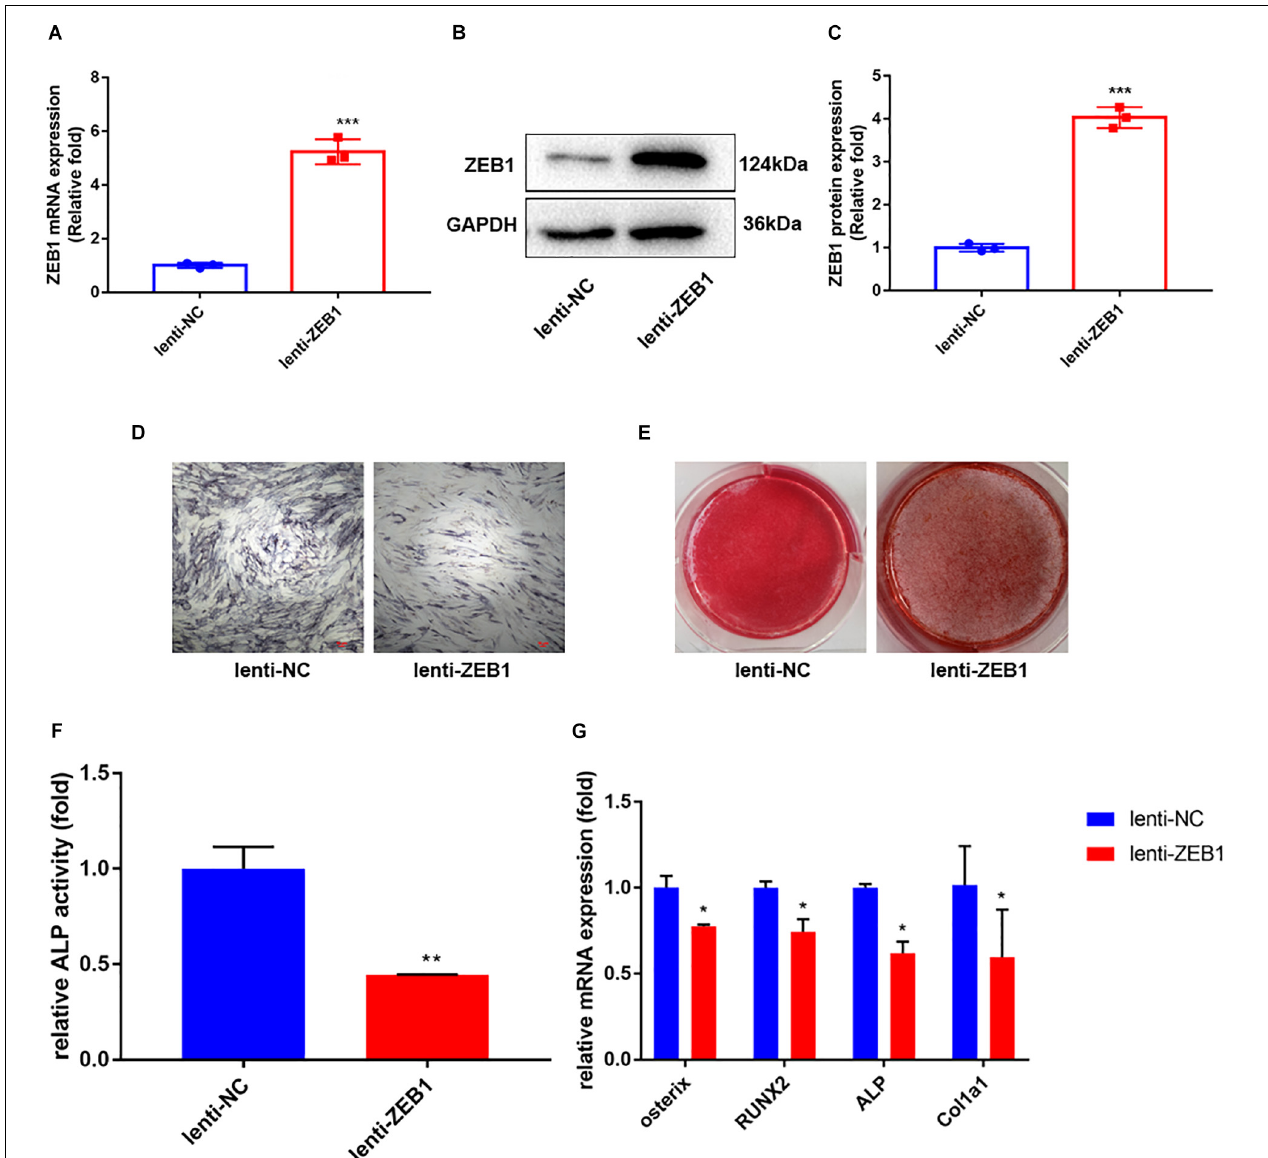
FIGURE 3 | Zinc finger E-box-binding homebox 1 (ZEB1) upregulation inhibited the osteogenesis of hBMSCs. (A) ZEB1 expression increased after lenti-ZEB1 treatment – evaluated by qRT-PCR. (B,C) ZEB1 expression increased after lenti-ZEB1 treatment – evaluated by western blotting. (D,E) ALP staining and alizarin red staining of hBMSCs after lenti-ZEB1 treatment. (F) ALP activity of hBMSCs after lenti-ZEB1 treatment. (G) qRT-PCR analysis demonstrated that lenti-ZEB1 treatment decreased the mRNA level of ALP, osterix, RUNX2, and Col1a1. * p -value < 0.05, ** p -value < 0.01 and *** p -value <